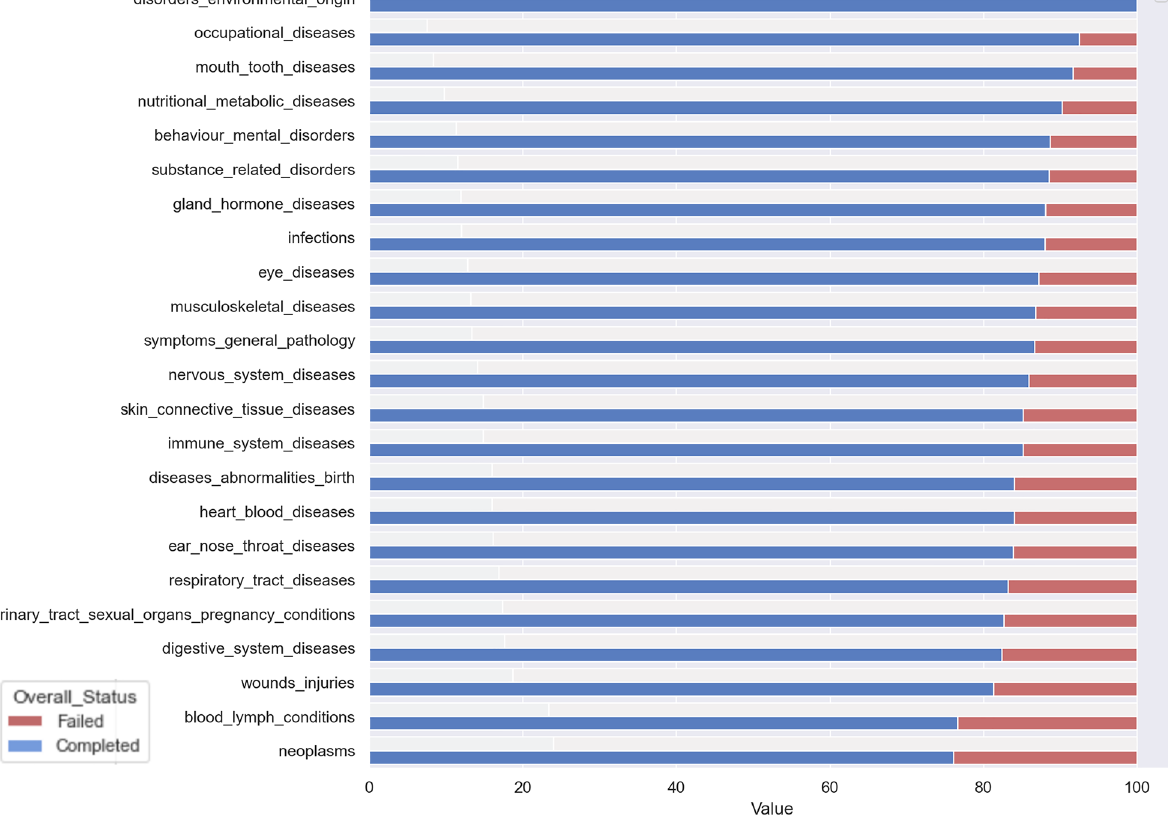
Figure 3. Percentage of completed to terminated studies for each disease category recorded on clinicaltrials.